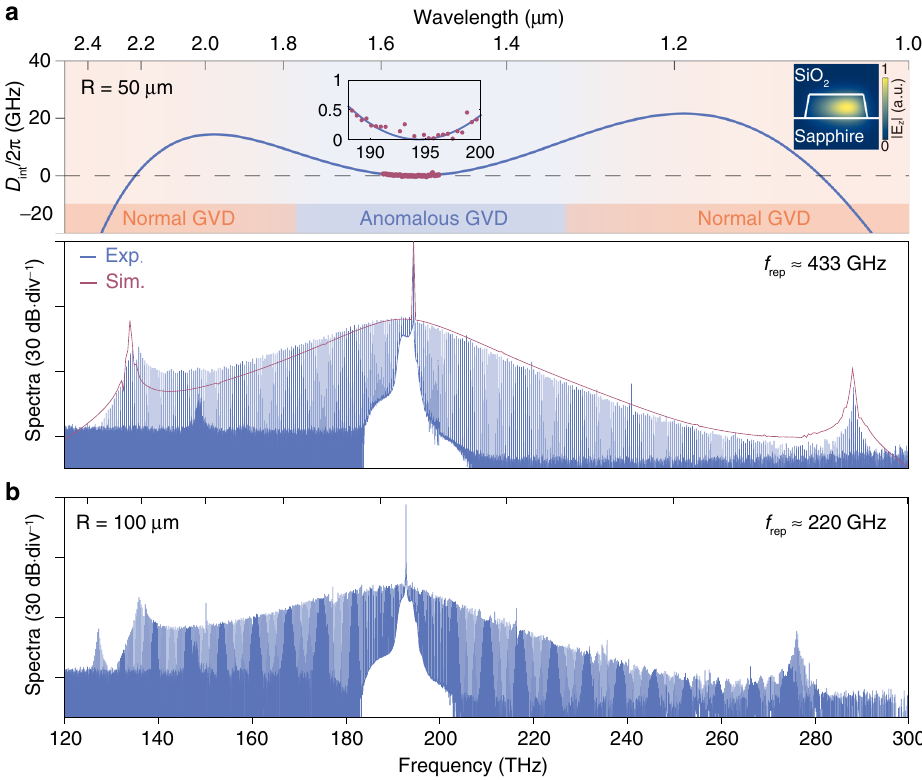
Fig. 2 Octave soliton microcombs at hundreds of gigahertz repetition rates. a Top: integrated dispersion ( D int ) of a 50 μ m-radius (R) AlN resonator (cross section: 1.0 × 2.3 μ m 2 ), where the anomalous and normal group velocity dispersion (GVD) regimes are indicated by solid light blue and orange colors in the bottom. Insets: zoom-in view of measured (red dots) and simulated (blue curve) D int values in the center, and electric fi eld abs( E z ) of the TM 00 resonator mode with a normalized color bar in the right. Bottom: soliton microcomb spectra from the experiment (Exp., blue curve) and simulation (Sim., red curve) at an on-chip pump power of ~390 mW. The resonator Q int is 1.6 million and the repetition rate ( f rep ) is estimated to be around 433 GHz. b Soliton microcomb spectrum from a 100 μ m-radius AlN resonator (cross section: 1.0 × 3.5 μ m 2 ) with a decreased f rep of ~220 GHz. The applied pump power is ~1 W at a resonator Q int of 2.5